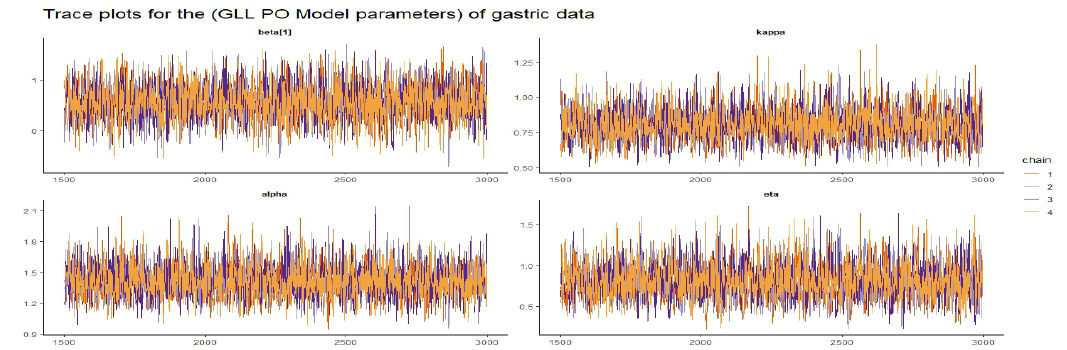
Figure 4. The GLL–PH model posterior parameters trace plots of the gastric cancer data.